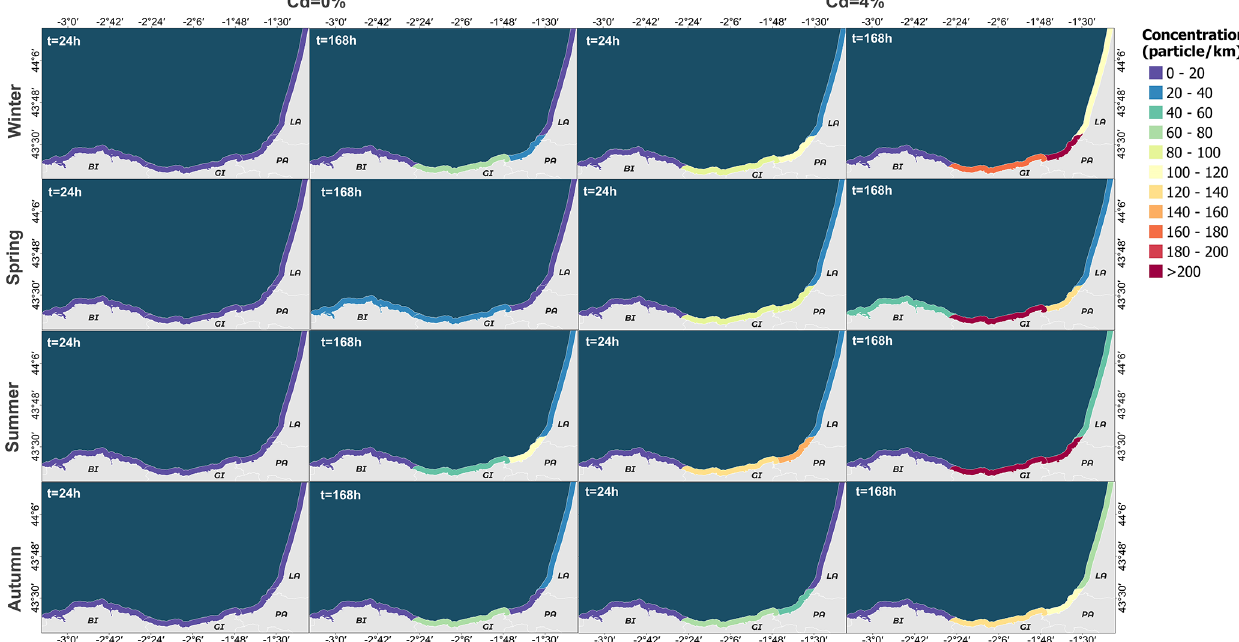
Figure 7. Particle concentration on the Bizkaia, Gipuzkoa, Pyrénées-Atlantiques, and Landes shoreline. The seasonal distribution is shown for C d = 0% and C d = 4% after 24 and 168h of simulation.